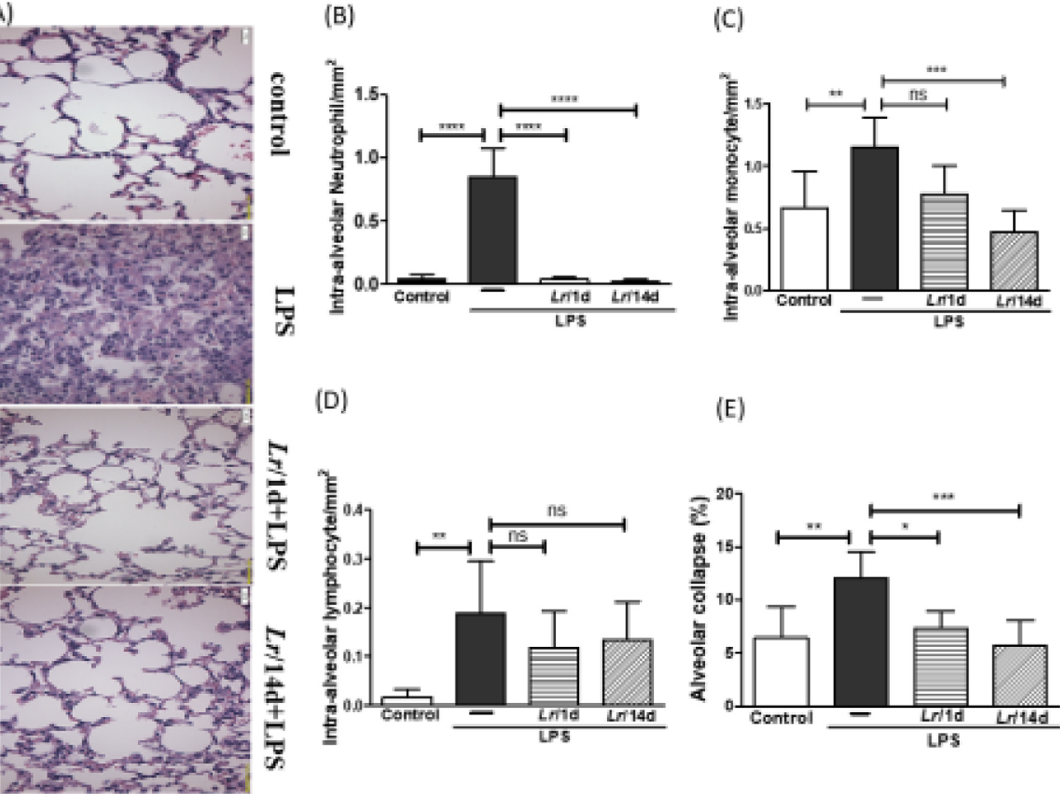
Fig. 9. Morphometry in lung (400 × ). The C57Bl/6 mice were treated with Lacticaseibacillus rhamnosus (10 9 CFU Lr in 300 µ L of PBS, gastric oro by gavage) for 14 days or one day, before E. coli LPS instillation (0.5 mg/Kg, intranasal). The mice were euthanized 24 h after the LPS. The histological sections were stained with H & E and the photomicroscopy of the parenchyma was performed using a microscope (OLYMPUS MODEL BX43F) and analyzed using the IMAGE PRO PLUS program. Photomicro- scopy (magni fi cation: 400 × ) (9A); Neutrophils (9B); monocytes (9C); lymphocytes (9D), and Alveolar collapse (9E). The results are expressed as mean ± SEM